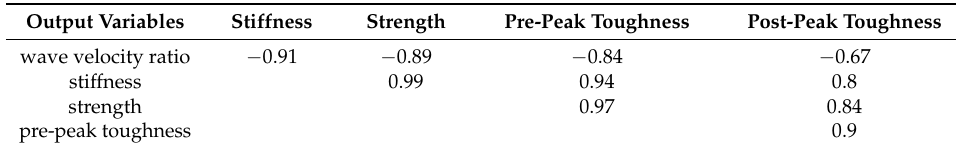
Table 3. Correlation coefficient between output